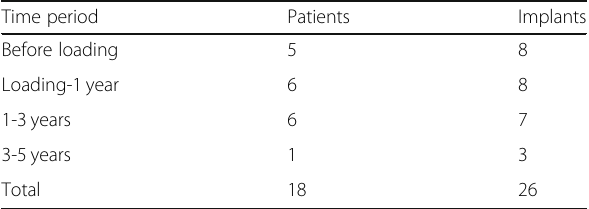
Table 1 Dropouts over observation